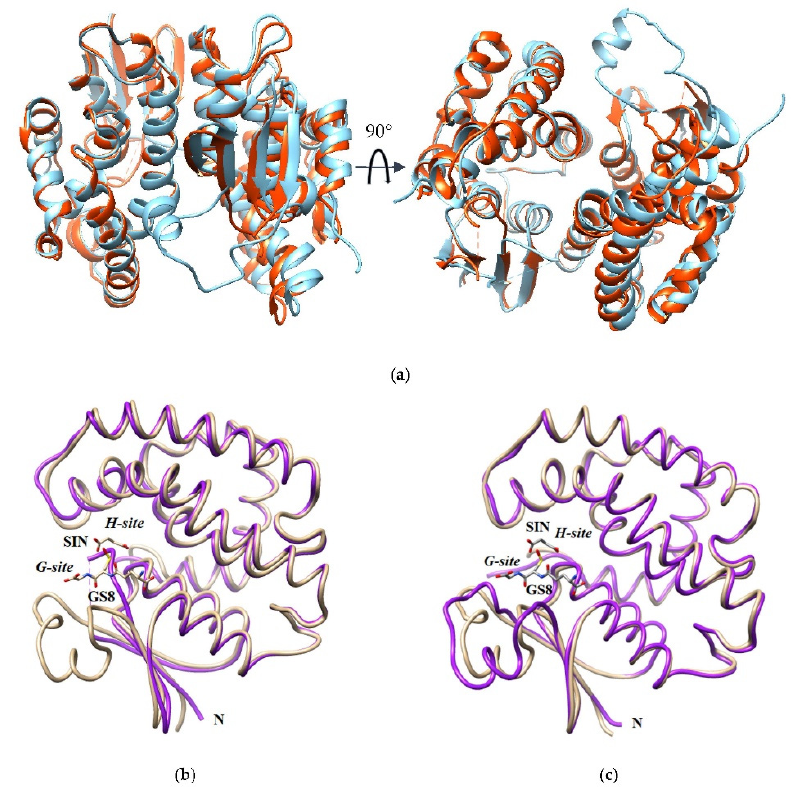
Figure 8. ( a ) Superposition of the sh101 (dark orange) and sh155 (blue) dimeric structures. The letter N represents the N-terminal site. ( b ) Superposition of the monomers of sh101 (purple) and Am GSTF (PDBid 6riv) (beige). The succinic acid (SIN) and glutathione sulfenic acid (GS8) molecules bound to the Am GSTF structure are shown as sticks and colored according to the atom type. ( c ) Superposition of the monomers of sh155 (purple) and Am GSTF (beige). The succinic acid (SIN) and glutathione sulfenic acid (GS8) molecules bound to the Am GSTF structure are shown as sticks and colored according to the atom